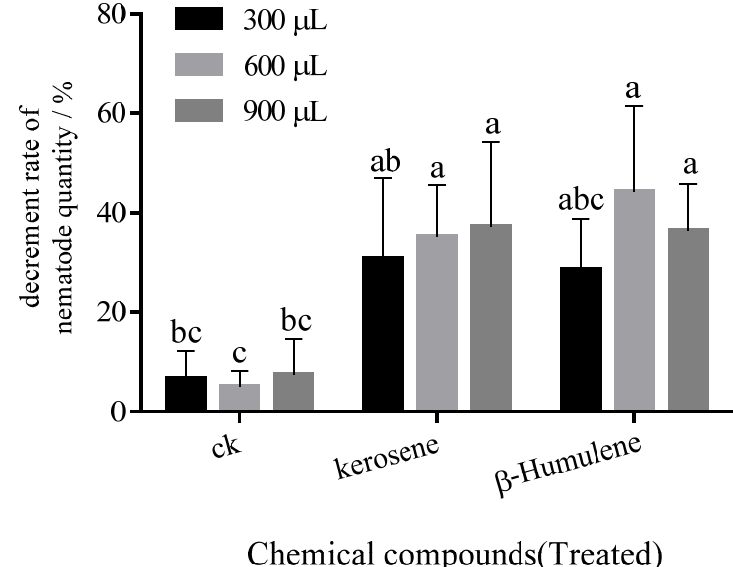
Figure 5. Changes in the number of PWN in infected trees after treatment with different repellent chemicals. Lowercase letters indicate the differences among